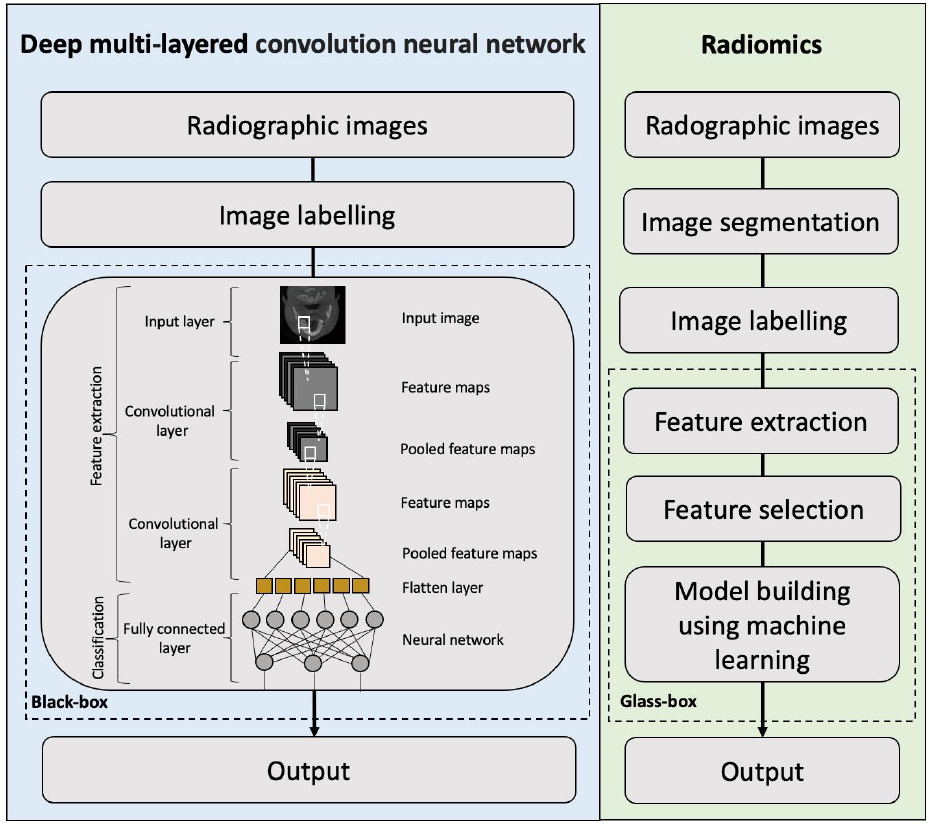
Figure 3. Flowchart demonstrating the main differences in the workflow between deep learning and radiomics in radiological studies.